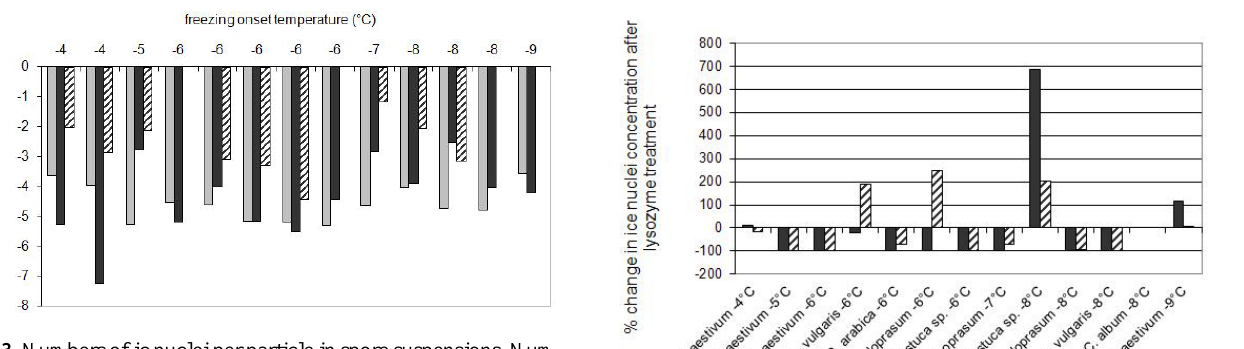
Fig. 3. Numbers of ic nuclei per particle in spore suspensions. Num- bers were calculated according to three hypotheses about the origin of the ice nuclei in the suspensions: that the ice nuclei are associated only with (i) the urediospores or the cells (grey bars) of (ii) the total bacteria (black bars) or (iii) Pseudomonas syringae (hatched bars) in the spore suspensions. The abundance of ice nuclei per spore or bacterial cells are presented in the order of decreasing freezing on- set temperature of the spore suspensions.